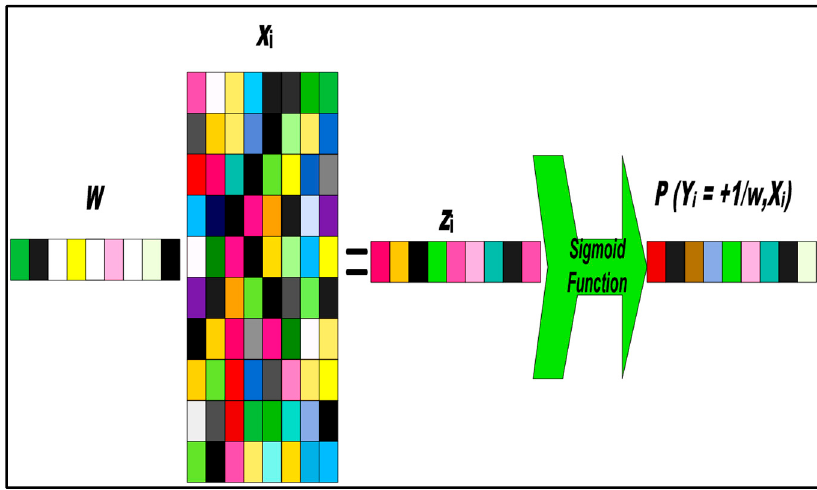
Figure 2. Sparse logistic regression (SPLR) (Lasso) feature selection. The w is sparse coefficient vector and white element in w the stand for zero elements (sparse data) and rest of all are selected